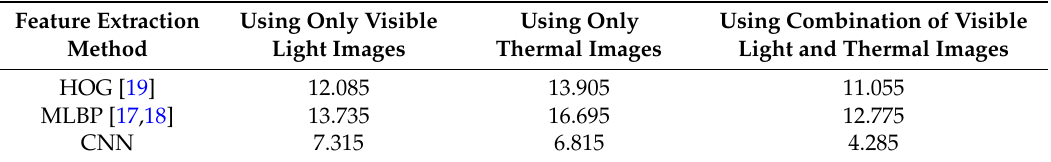
Table 4. Verification performance (EER) of the recognition system using Euclidean distance without applying PCA on extracted image features (unit: